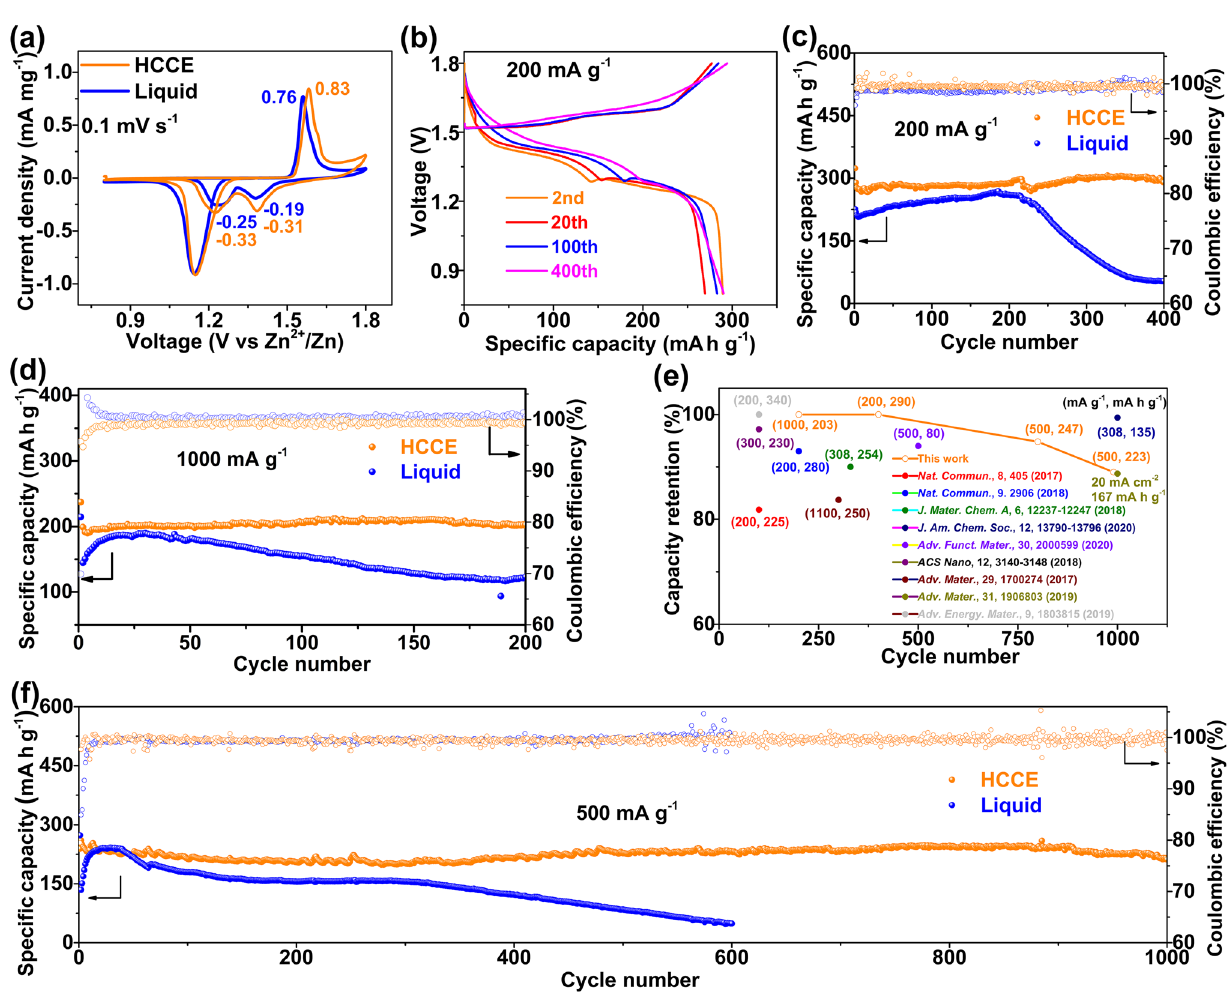
Fig. 2 a CV curves (the first cycle) at a scan rate of 0.1 mV s −1 with the HCCE and liquid electrolyte. b Charge–discharge curves under differ- ent cycles with the HCCE at 200 mA g −1 . c Cycling performance of the cell with HCCE and liquid electrolyte cells at 200 mA g −1 . d Cycling performance of the cell with HCCE and liquid electrolyte cells at 1000 mA g −1 . e Capacity retention versus cycle number for electrolyte reported in aqueous Zn/mangan-based materials (mainly manganese dioxide) batteries, note: the current density and final specific capacity are indicated in the figure. f Long-life cycling performance of the cell with HCCE and liquid electrolyte at 500 mA g